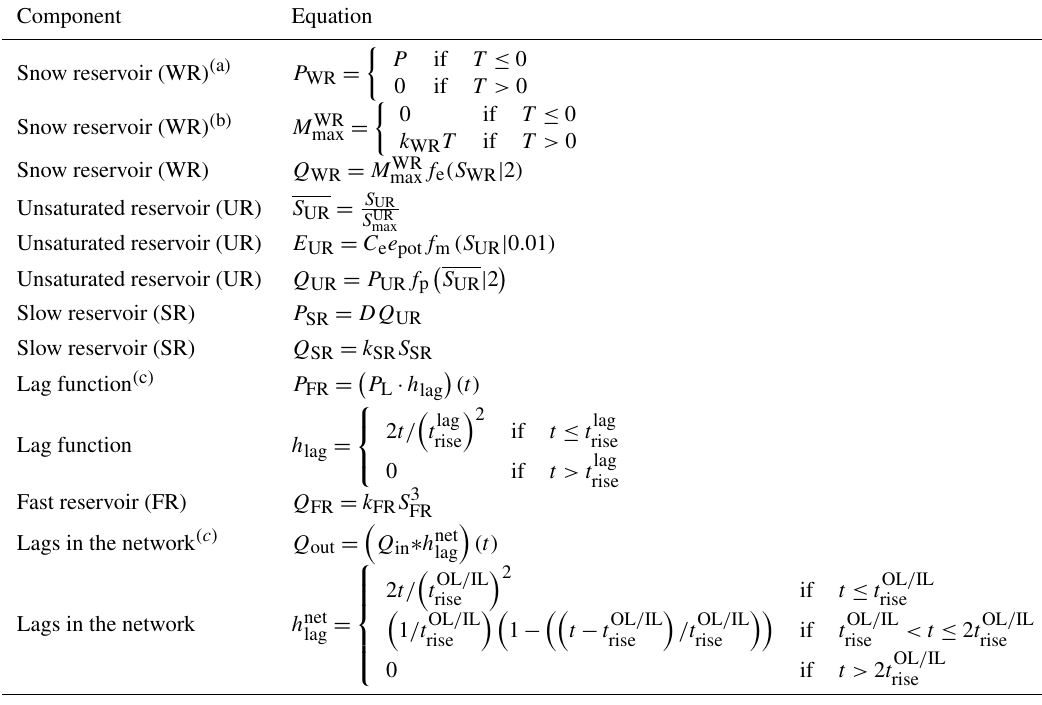
Table A3. Constitutive functions of the model. Refer to Table A4 for the definition of the functions f . Component Equation Snow reservoir (WR) ( a )